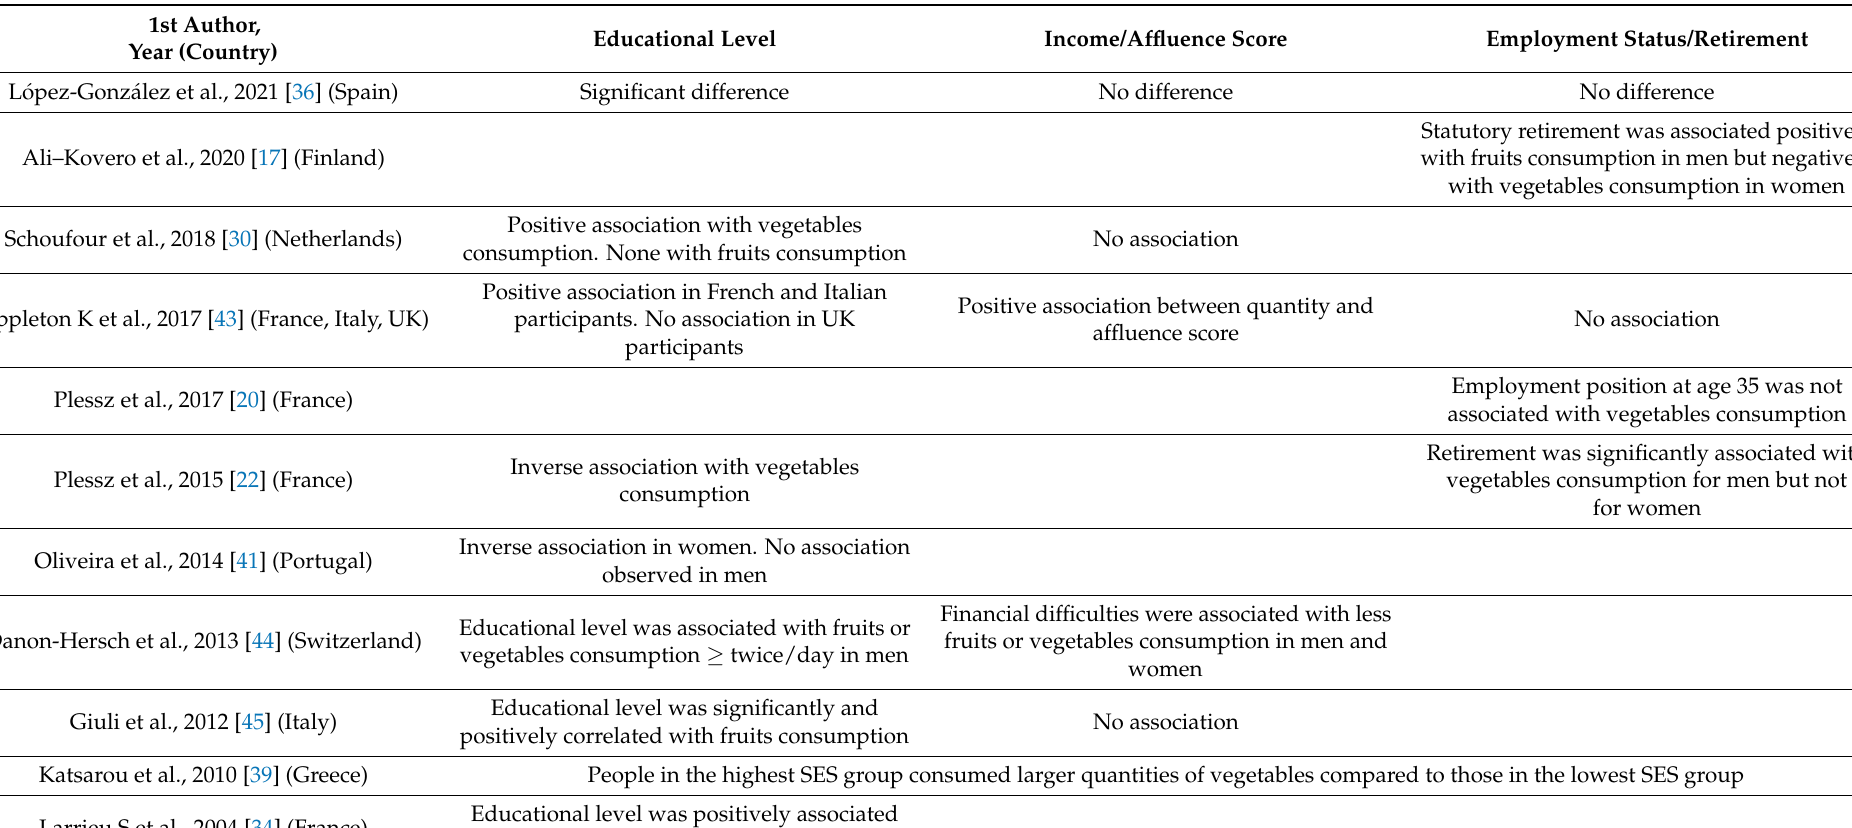
Table 5. Association between socioeconomic status (SES) determinants and fruits and vegetables